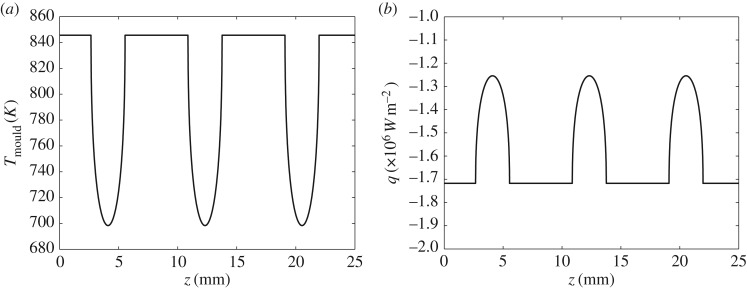
(a) Temperature at the mould wall, Tmould; (b) heat flux at the mould wall, q.